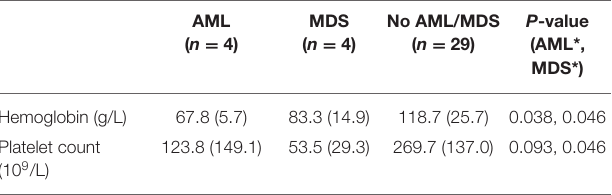
TABLE 2 | Comparison of hemoglobin and platelet levels between Sweet syndrome patients with and without AML/MDS [mean